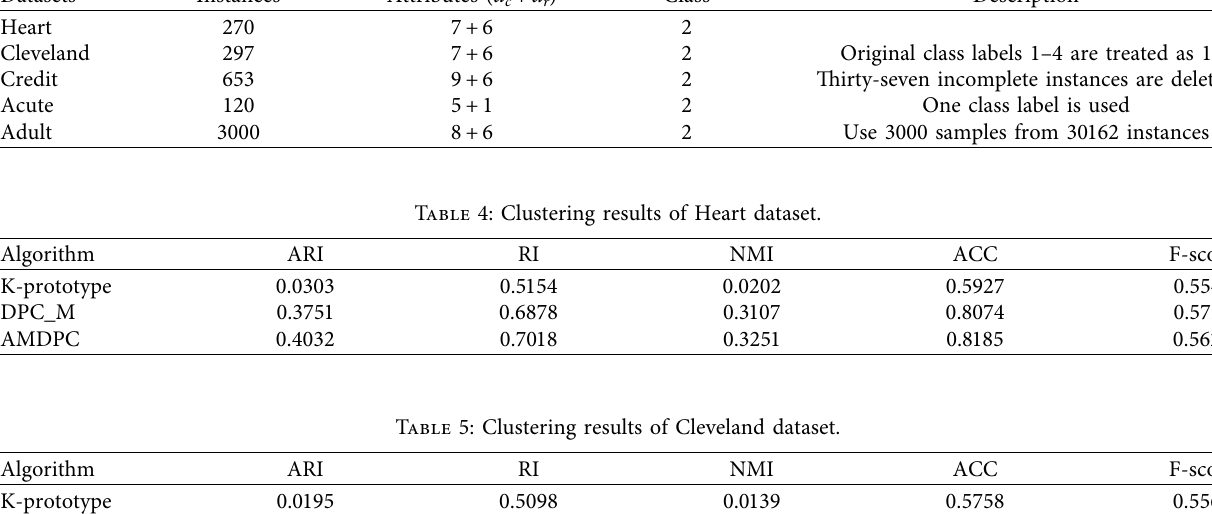
graphs for center selection by the two aforementioned clustering types using the DPC_M algorithm (that is, DPC_M1 and DPC_M2) are shown in Figure 3.